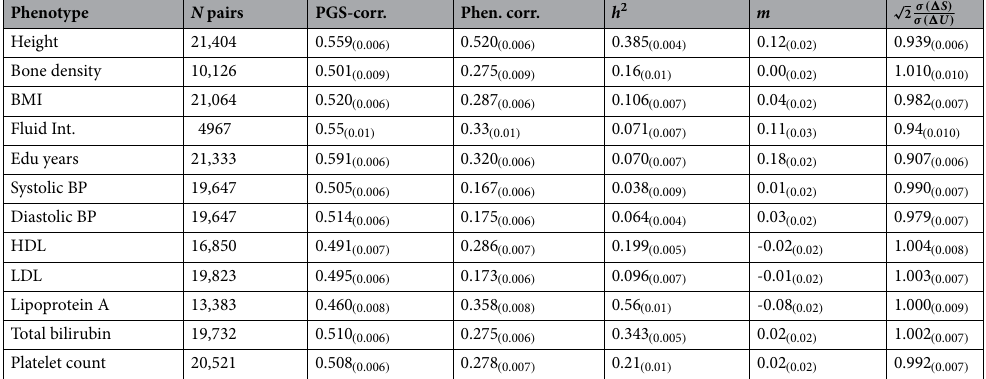
Table 1. Descriptive population genetics results for sibling quantitative traits: the ratio of unrelated ( U ) vs sibling ( S ) standard deviations holds to be √ 2 . Correlation in PGS and phenotypes (adjusted by sex) between pairs of siblings, trait heritability, and assortivity m for quantitative traits. σ(� U ) is the standard deviation of the PGS-difference among unrelated individuals and σ(� S ) is the corresponding standard deviation among siblings. Computed using UKB siblings of either sex. All uncertainties, listed in parentheses, are standard errors.